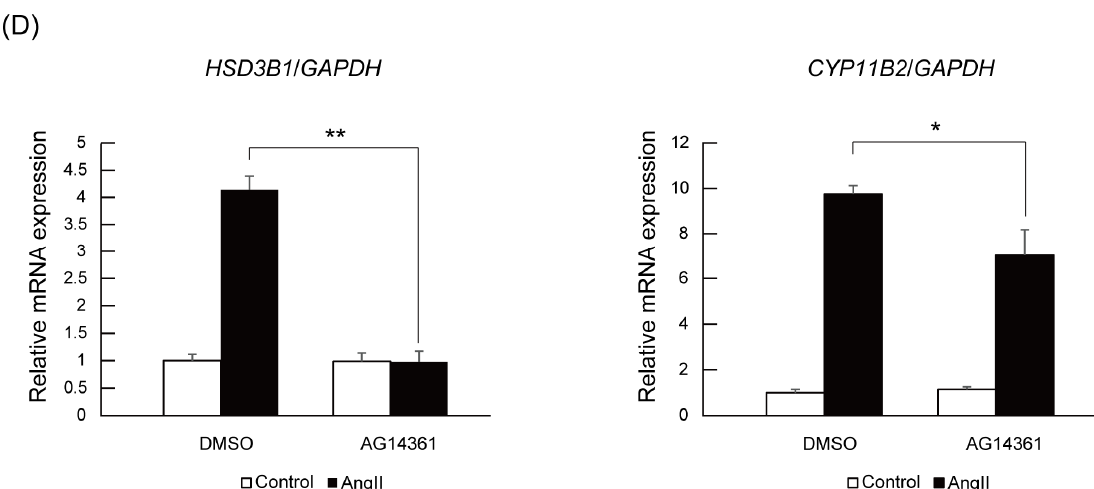
Figure 3. PARP1 is a Nurr1 coactivator in H295R cells . ( A ) Coactivator activity of PARP1 with Nurr1. 293F cells were transiently transfected with pGL4.10 vector (100 ng each), which contains four copies of NBRE sequences, and with FLAG-Nurr1 (50 ng each) and/or HA-PARP1 (0, 50, 100, 250 ng) expression vector. Luciferase (Luc.) activity was normalized to the β-gal internal control. The p value was calculated by student’s t -test ( n = 4). The error bars indicate standard deviations. *, p < 0.05, **, p < 0.01; ( B ) Confirmation of knockdown by siRNA. H295R cells were transfected with siRNAs and incubated for 24 h. After incubation, cells were stimulated with or without 100 nM angiotensin II for 6 h and examined for the expression of PARP1 by quantitative PCR. The expression levels of the PARP1 gene were normalized to the endogenous GAPDH gene. The error bars indicate standard deviations. The p value was calculated by Student’s t -test ( n = 3). *, p < 0.05, **, p < 0.01; ( C ) The effect of PARP1 knockdown on angiotensin II-induced Nurr1 target gene expression was assessed by qPCR. The expression levels of the indicated genes were normalized to the endogenous GAPDH gene. The error bars indicate standard deviations. The p value was calculated by Student’s t -test ( n = 3). *, p < 0.05, n.s., not significant; ( D ) The effect of PARP1 inhibitor AG14361 on angiotensin II-induced Nurr1 target gene expression was assessed by qPCR. Cells were treated with 10 μM of AG14361 and 100 nM angiotensin II for 6 h. The expression levels of the indicated genes were normalized to the endogenous GAPDH gene. The error bars indicate standard deviations. The p value was calculated by Student’s t - test ( n = 3). *, p < 0.05, **, p < 0.01.